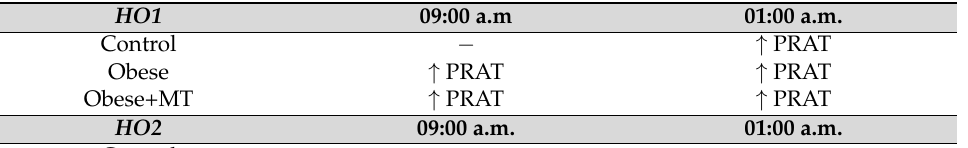
Table 1. Comparison of the relative gene expression of each redox enzyme between the two adipose fat depots (PRAT vs. SAT) at the same schedule. Values normalized with the 09:00 a.m. controls. Arrows indicate whether the relative gene expression of each enzyme is increased ( ↑ ) or reduced ( ↓ ) comparing same group and schedule, but different